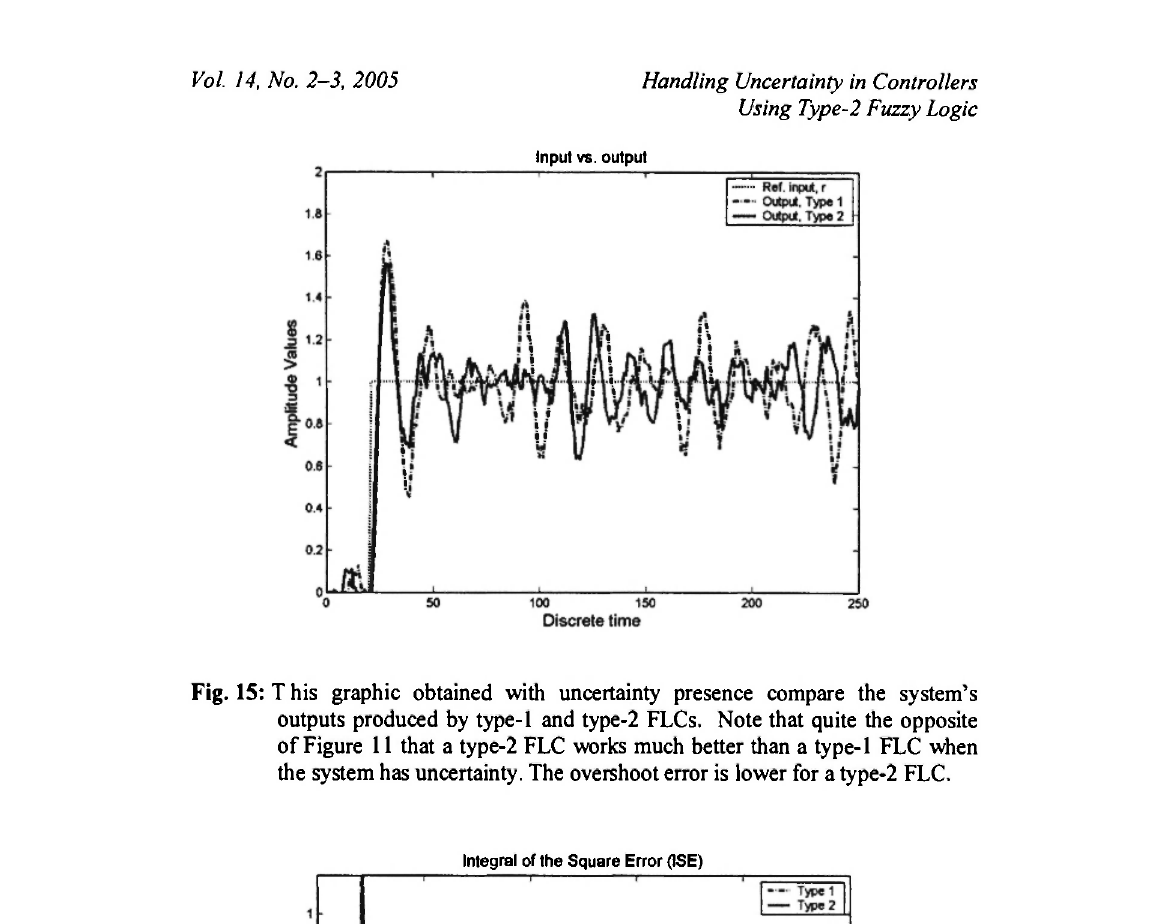
Fig. 15: Τ his graphic obtained with uncertainty presence compare the system's outputs produced by type-1 and type-2 FLCs. Note that quite the opposite of Figure 11 that a type-2 FLC works much better than a type-1 FLC when the system has uncertainty. The overshoot error is lower for a type-2 FLC.